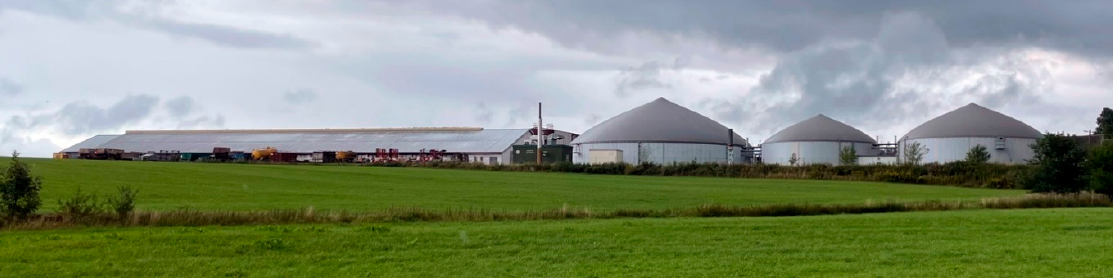
Figure 3. Biogas station on part of the area of a former collective farm. Image by Tomáš Krej č í (Chlumec near Da č ice, the Czech Republic, 4 June 2021).